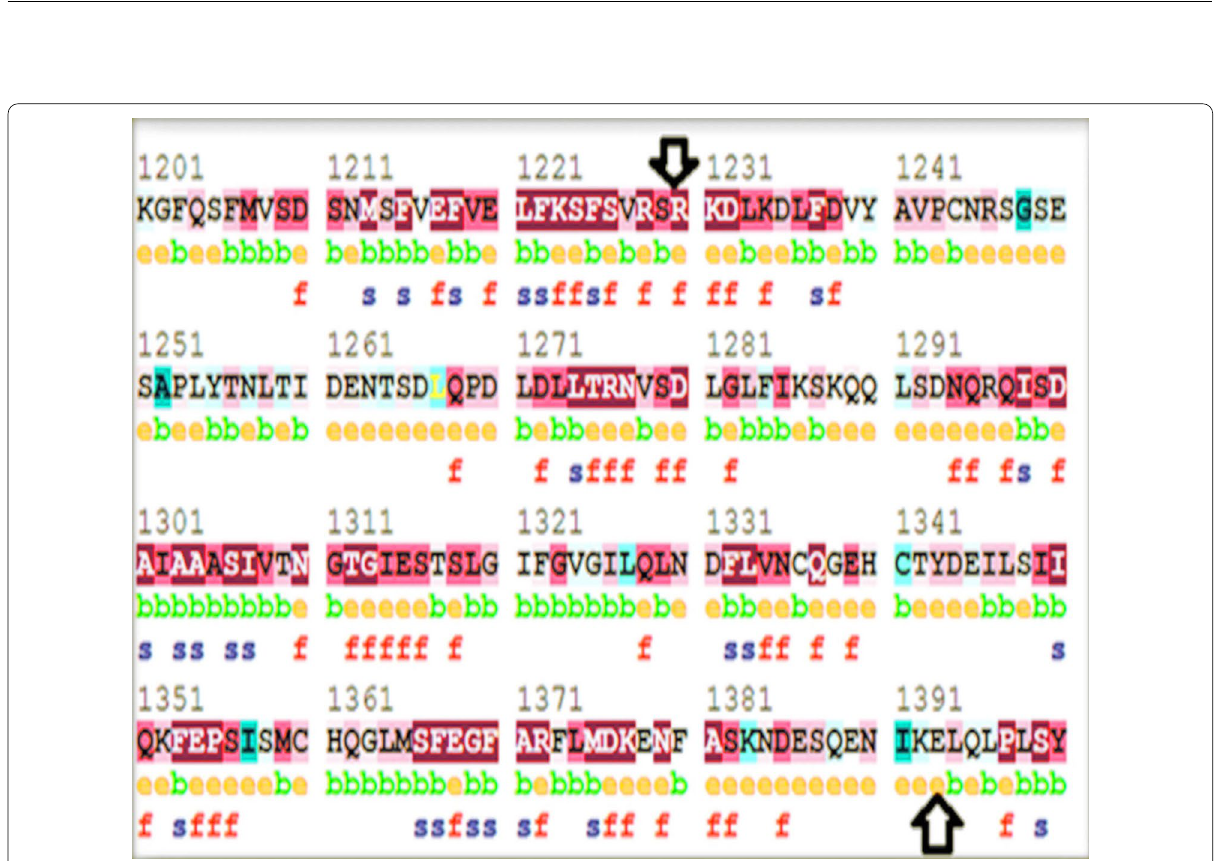
Fig. 3 The conservation score obtained according to Consurf prediction score. The arrows indicating the position of two novel mutations at R1230 and at E1393. Symbol characters (e) indicate the amino acid position is exposed (f) indicate that the amino acid position is predicted functional residue (highly conserved and exposed). b indicate that the amino acid position is a buried residue (s) indicate that the amino acid position is predicted structural residue (highly conserved and buried)